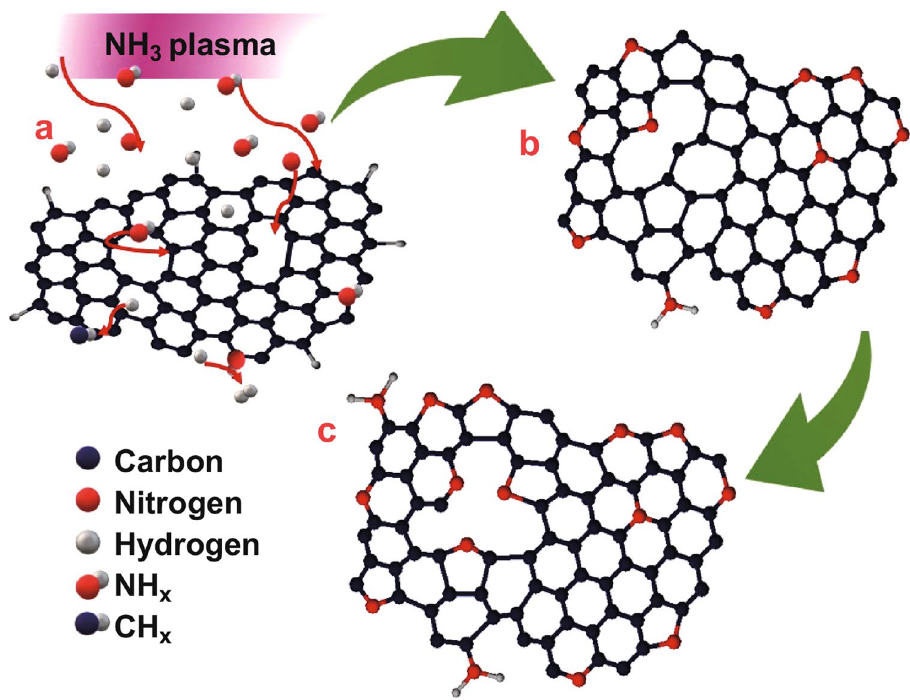
Fig. 6 Schematic diagram of the plausible mechanism of nitrogen incorporation in CNWs using NH 3 plasma post-treatment: a the interaction of plasma species with defects, b the substitution of N-atoms in the SV to form graphitic N and incorporating N at DV to form pyrrolic N, and c the transformation of pyrrolic N to form pyridinic N along with pyrrolic N at